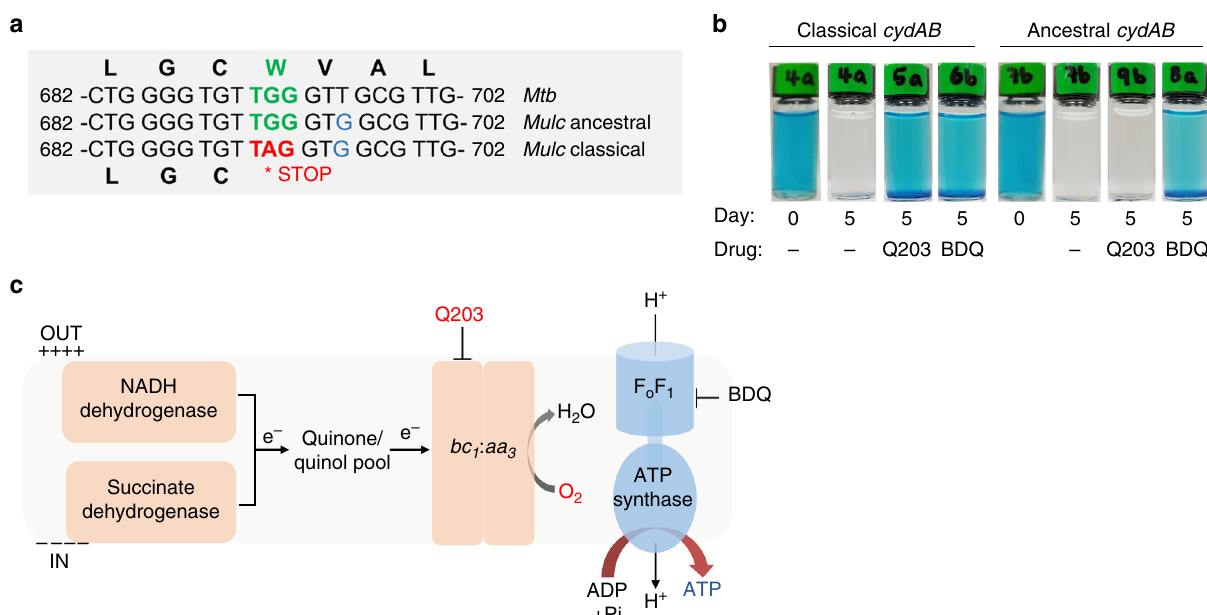
Fig. 1 The cytochrome bc 1 :aa 3 is the sole respiratory terminal oxidase in classical M. ulcerans strains. a A single-nucleotide polymorphism (692G>A) converting the tryptophan-encoding codon TGG into the stop codon TAG is present in cydA of all classical M. ulceran s strains. b The cydAB operon present in classical M. ulcerans strains does not encode a functional cyt- bd . Q203-treated M. bovis BCG Δ cydAB strains complemented with the cydAB operon from classical lineage, or from Japanese ancestral lineage strains were incubated with Q203 (100 nM) in sealed tubes containing 0.001% methylene blue used as an oxygen sensor. Pictures were taken immediately after closing the tubes (day 0), and 5 days after incubation at 37 °C. Bedaquiline (1 mM) and